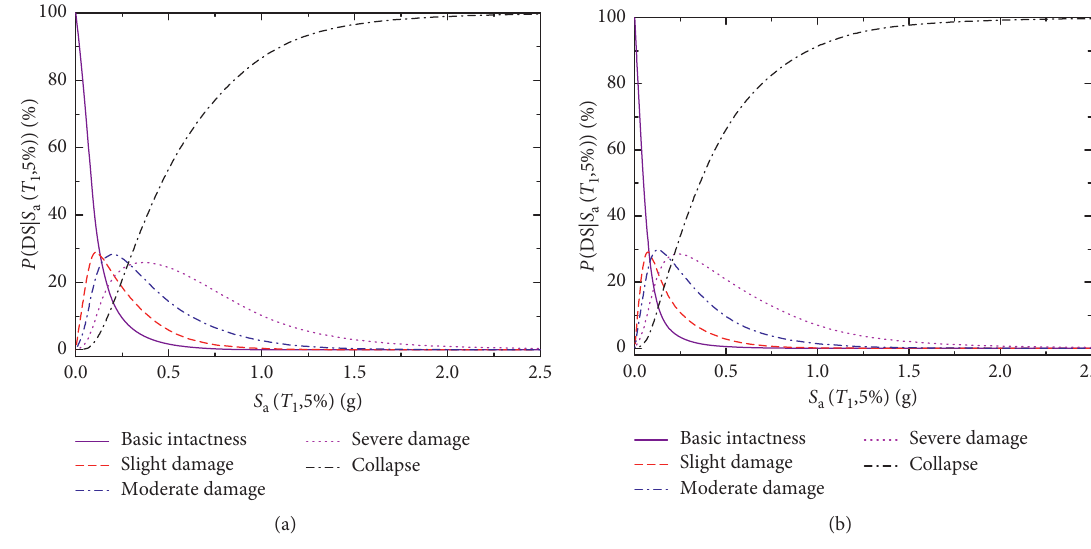
Figure 17: Probability curves of various damage states. (a) Main shock. (b) Main Table 13: Damage state and its corresponding damage index [30].